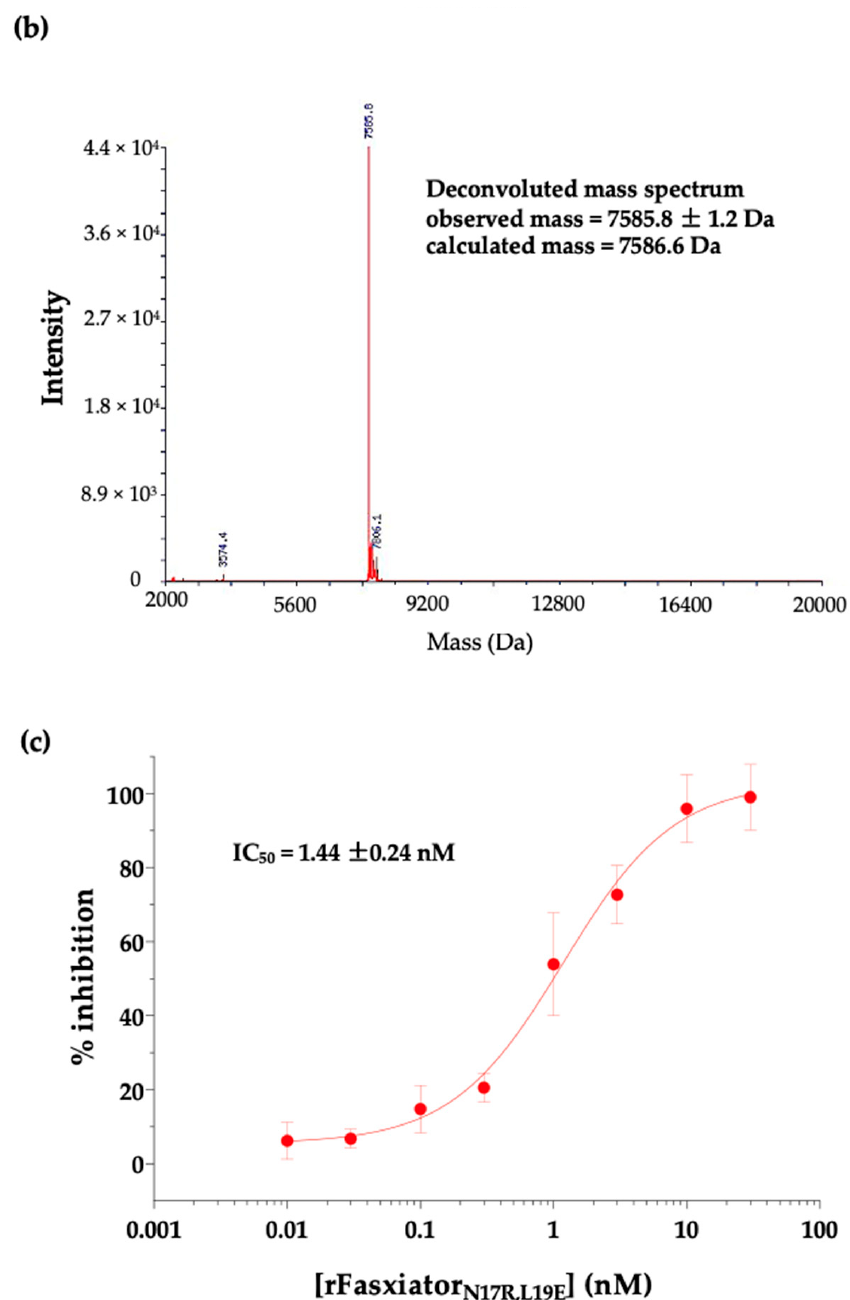
Figure 2. Purification and validation of FXIa inhibition by rFasxiator N17R, L19E. ( a ) RP-HPLC chromatogram of rFasxiator N17R, L19E . The arrowed peak indicates the elution of rFasxiator N17R, L19E . ( b ) ESI-MS deconvoluted spectrum of purified rFasxiator N17R, L19E with an observed mass of 7585.8 Da, consistent with the mass of the protein calculated from the amino acid curve of FXIa inhibition by rFasxiator N17R, L19E with IC 50 = 1.44 ± 0.24 nM ( n = 5).